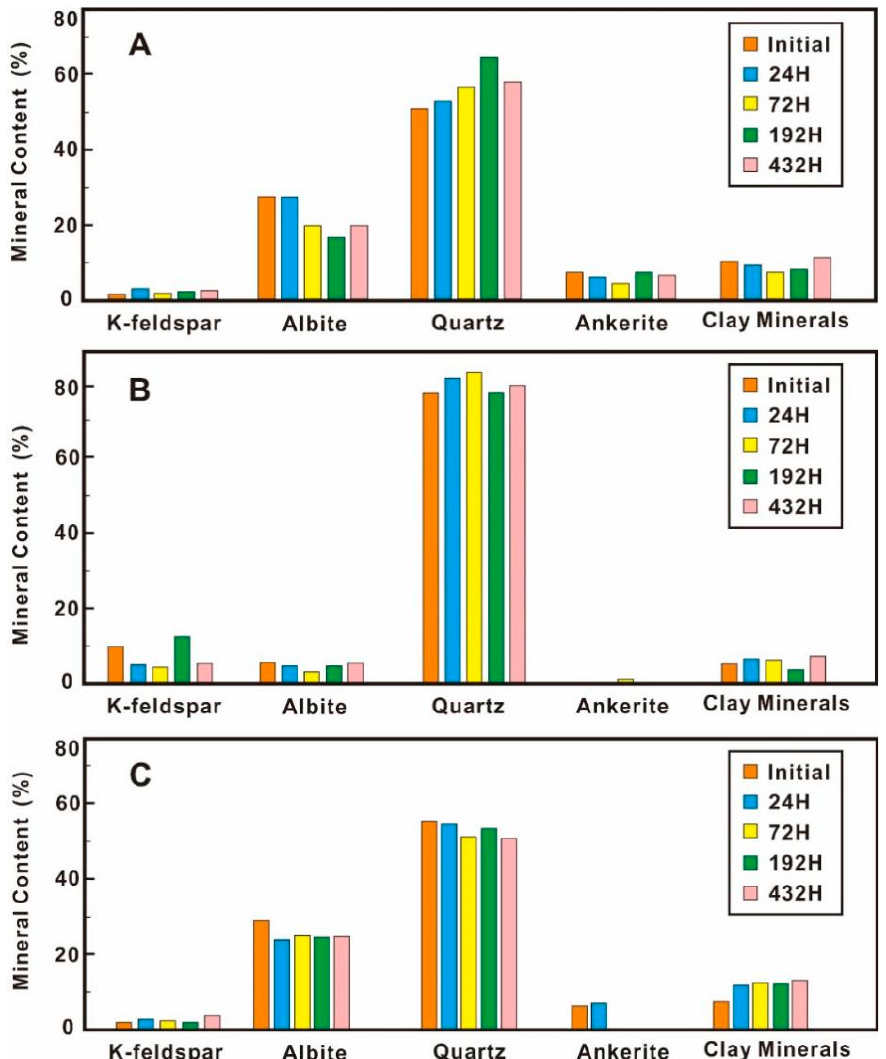
Figure 3. Mineralogy variation during different stages of CO 2 -water-sandstone interaction experiment. ( A ) Sample A-130; ( B ) Sample Q-147; ( C ) Sample Q-148. The mineral content changed during different CO 2 -water-rock interaction